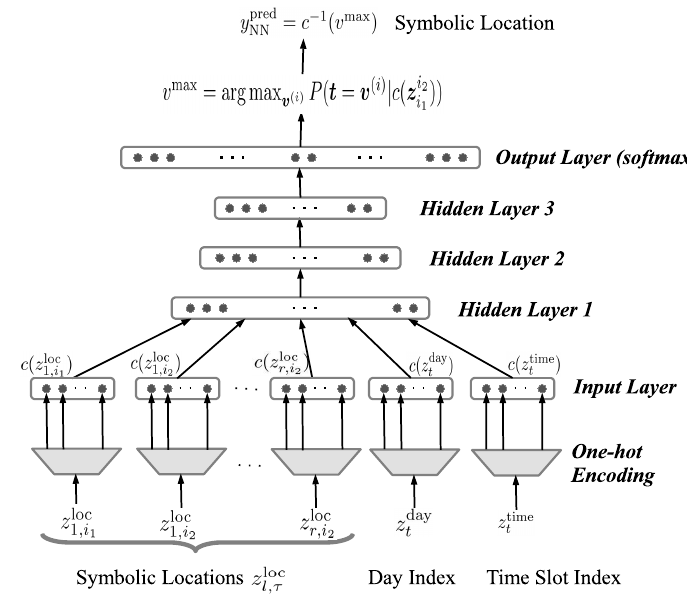
Figure 4. The PCM-based location prediction